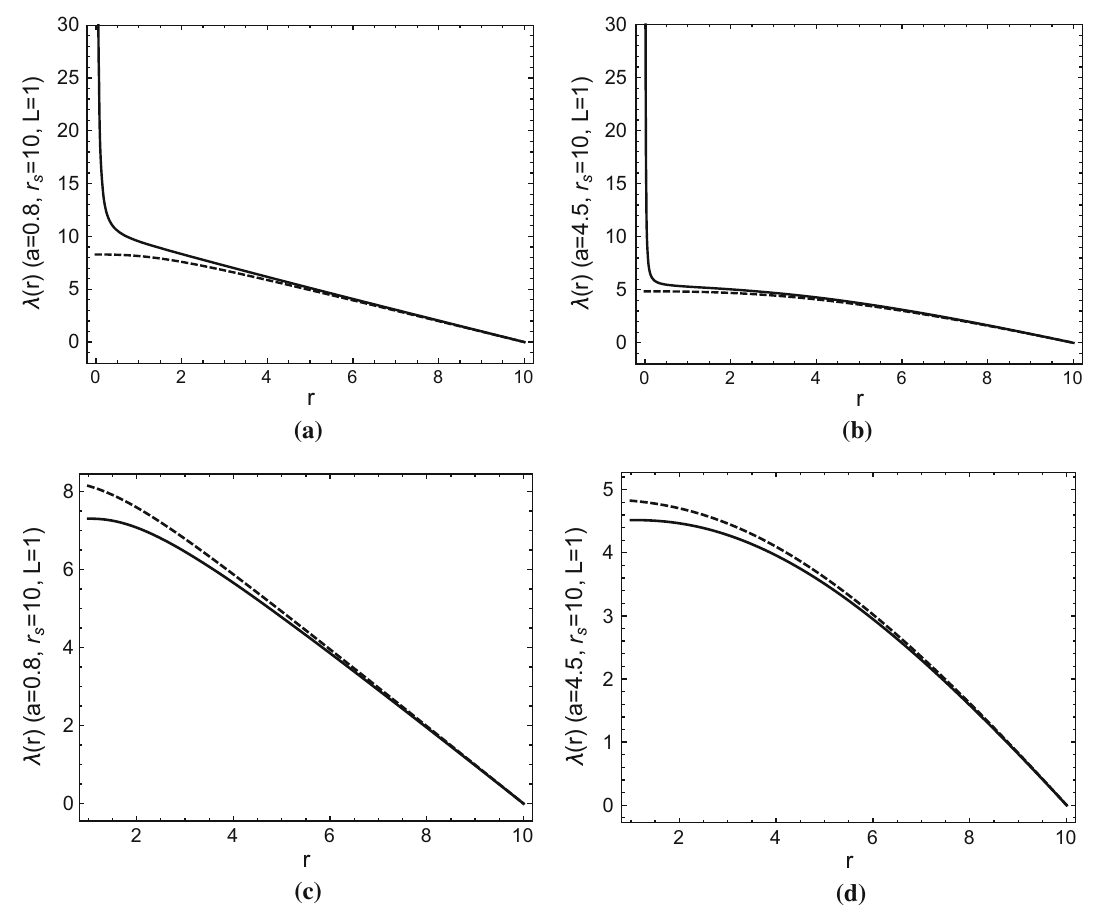
Fig. 1 Hereweemploythefollowingvaluesfortheparametersandthe conserved quantities: L = 1 , r in = 10 , a = 0 . 8 ,θ = π/ 2, and r s = 10 for a and c , L = 1 , r in = 10 , a = 4 . 5 ,θ = π/ 2, and r s = 10 for b and d . The dashed line shows the situation for the standard Kerr metric. a Plot of the affine parameter λ( r ) for an infalling massless particle